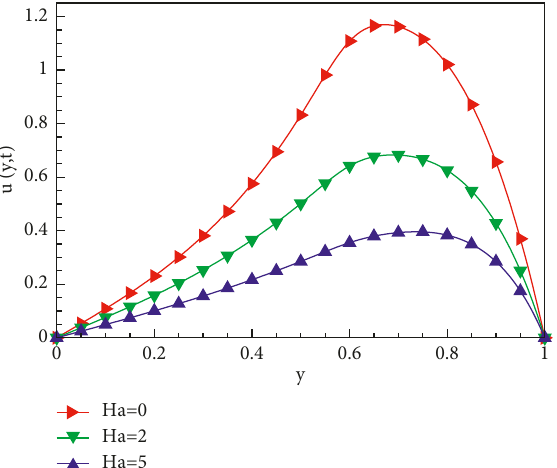
Figure 4: Influence of Ha on u when α � β � 1 , λ α